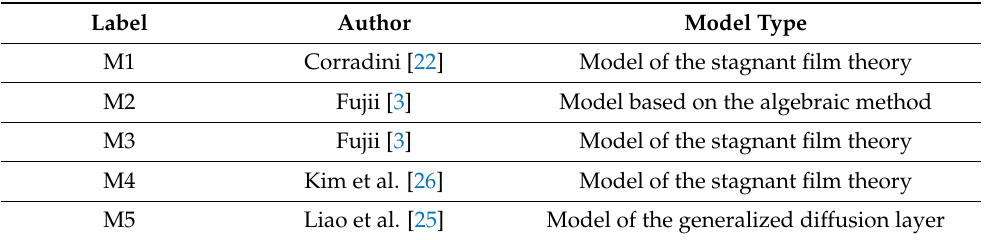
Table 2. Existing models used for the comparison with the experimental results for the case of the condensation of water vapour on vertical flat